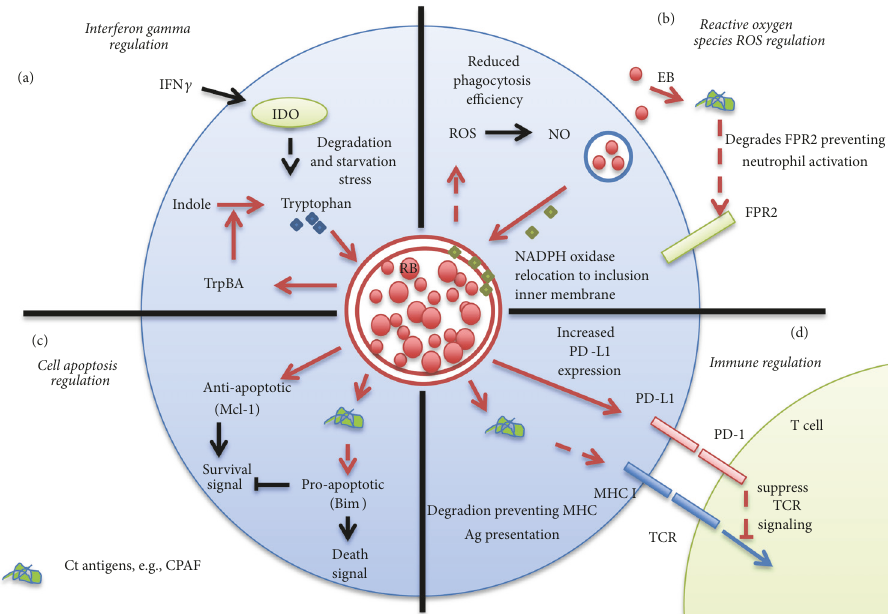
Figure 1: Immune evasion tactics utilized by Chlamydia sp. (a) Release of interferon 𝛾 (IFN 𝛾 ) from immune cells induces expression of Indoleamine2,3-dioxgenase (IDO) whichdegrades tryptophan, an essentialamino acid required for Chlamydia sp. replication. IDO-mediated tryptophan depletion gives rise to bacterial stress, i.e ., starvation. Under such conditions, Chlamydia sp. can produce tryptophan synthase (TrpBA) that converts indole to tryptophan. To avoid a ‘continuous’ stress situation, Chlamydia sp. enters a ‘persistence’ stage until which time the supply of tryptophan is restored. (b) Chlamydia sp. suppresses production of reactive oxygen species (ROS) and nitric oxide (NO) reducing the efficiency of phagocyte bacterial killing in phagolysosome. NADPH oxidase which is typically located on the phagolysomal membrane assists in production of bactericidal Myeloperoxidase (MPO) and hypochlorous acid (HOCl − ). In Chlamydia -infected cells, the subunit of NADPH oxidase is relocated to the inner membrane of the inclusion rather than the phagolysosome. As a consequence, Chlamydia sp. are able to survive in the phagocyte. In the neutrophil, production of chlamydial antigens such as Chlamydial -protease-like activity factor (CPAF)causesdegradationofneutrophilsurface formalpeptidereceptor inhibitingactivationofneutrophilsimpedingneutrophilextracellular trap(NET) activity.(c)Release of CPAFfrom Chlamydia sp. inducesexpression of antiapoptotic molecule myeloidleukemiacelldifferentiation protein (Mcl-1) promoting degradation of proapoptotic molecules such as BCL-2-like protein 11 (Bim). Thus, Chlamydia sp. block host cell apoptosis leading to a longer period of persistence, i.e ., replication within host cells. (d) CPAF degrades the major histocompatibility complex (MHC) preventing antigen presentation to T cells. Additionally, Chlamydia sp. increases PD-L1 expression in host cells. Binding of PD-L1 to the PD-1 receptor on the T cell surface constitutes a negative signal suppressing T cell receptor (TCR) activation signaling. Broken